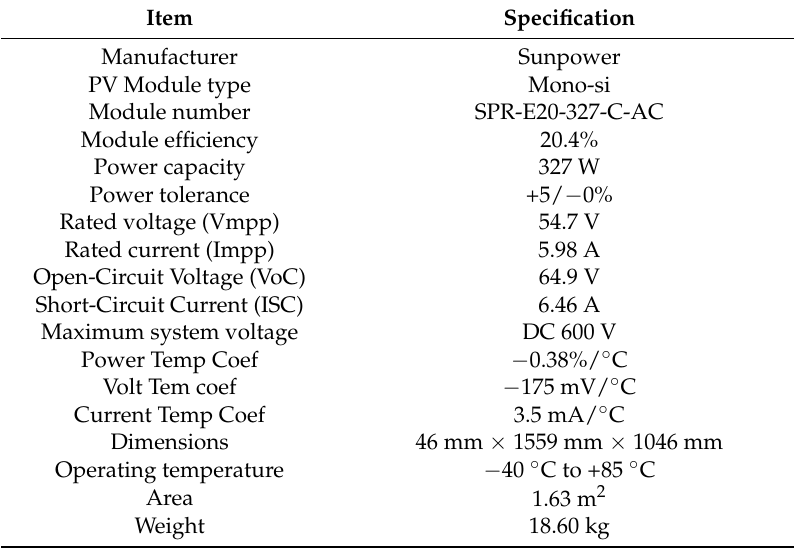
Table 6. PV module specifications